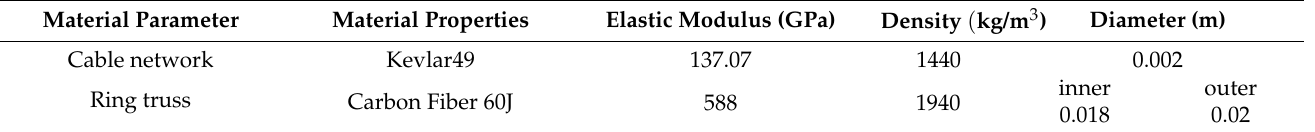
Figure 9. Three views of the antenna structure. Table 1. Material parameters of the structure.